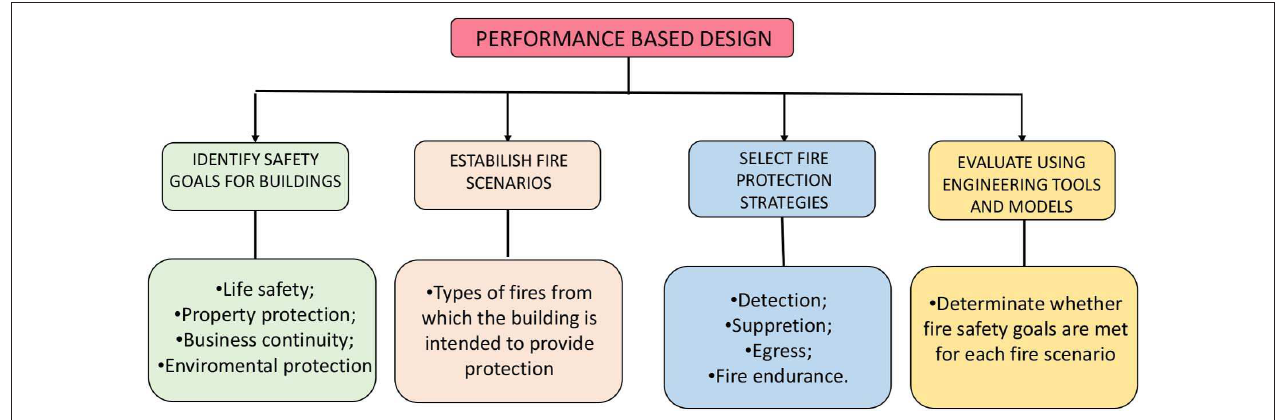
FIGURE 8 | Schematic Fire Engineering Approach (FEA)